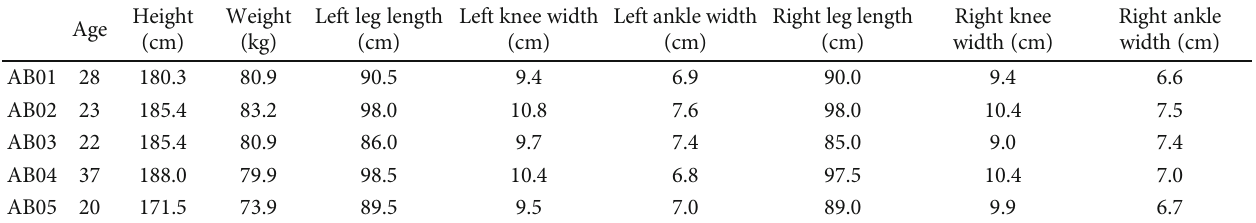
Table 1: Demographic and anthropometric data for the subjects with intact limbs.